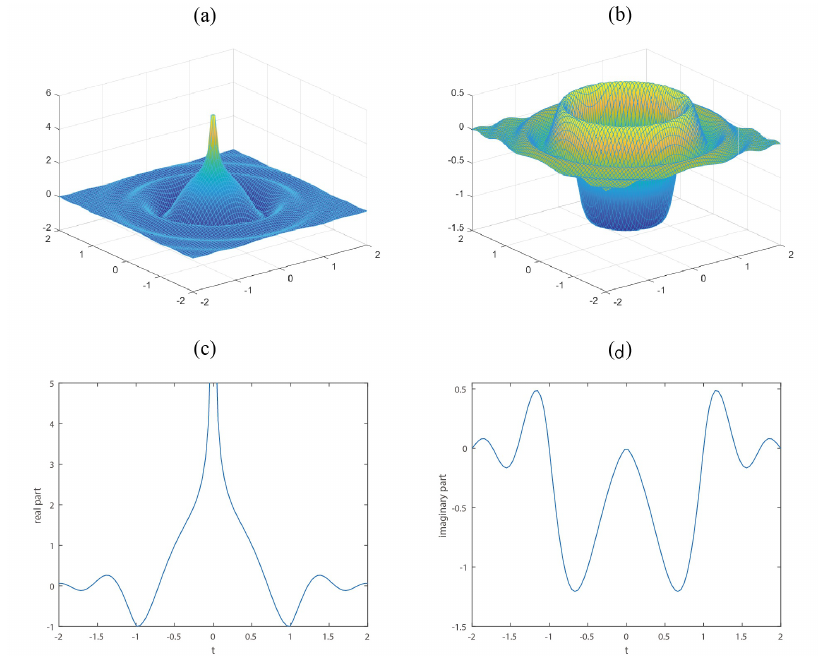
Figure 1. ( a ) Real part graph of f ( x ) , ( b ) imaginary part graph of f ( x ) , ( c ) section view of real part, ( d ) and section view of imaginary